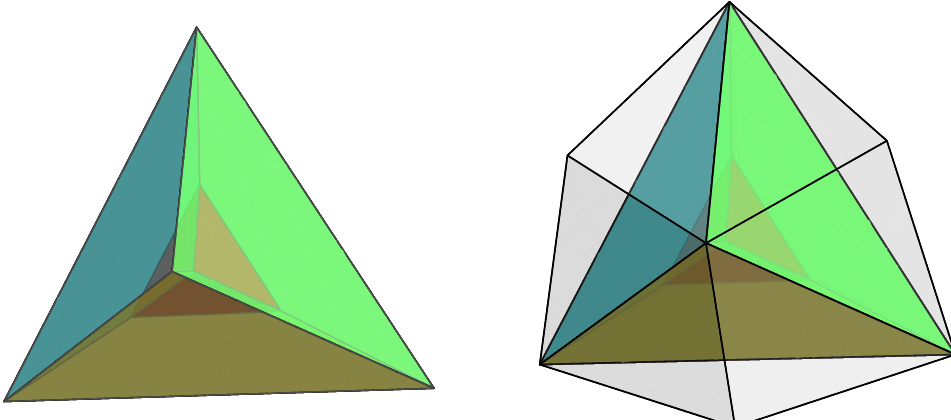
Figure 13 . This (cid:12)gure shows a partial construction in 3 dimensions of the 4 dimensional situation depicted in (cid:12)gure